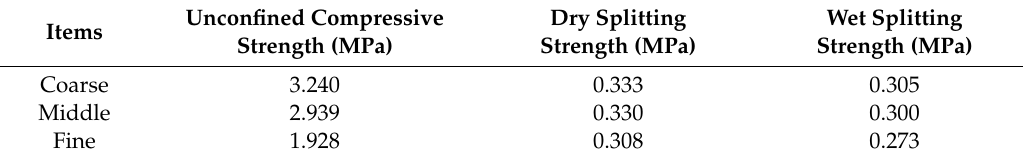
Table 5. Intensity of different grades.